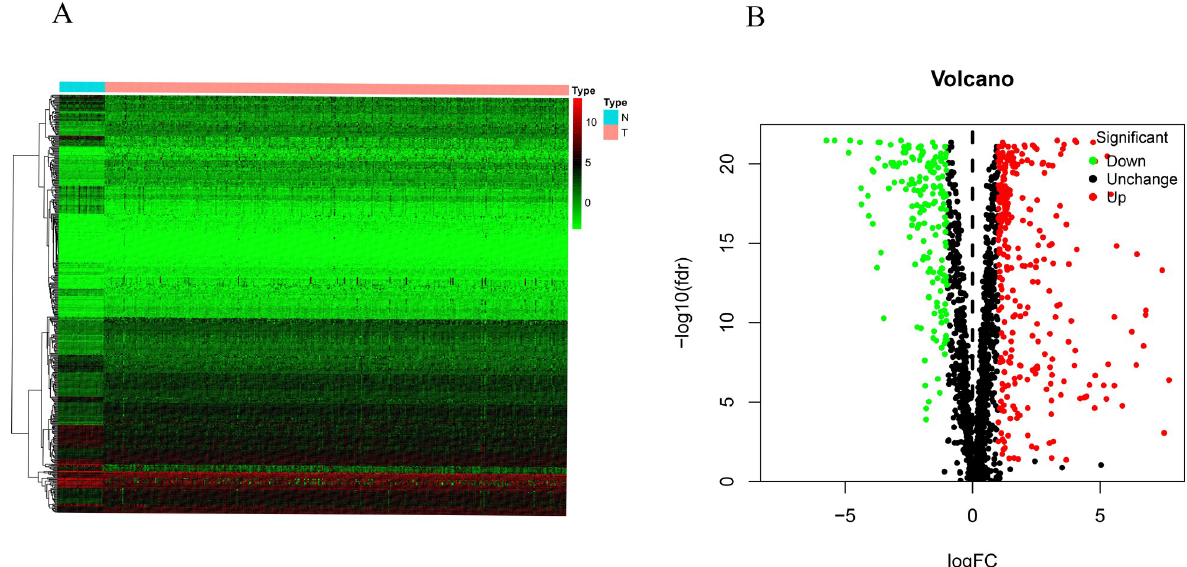
Fig 1. Heatmap and (B) volcano plot of differentially expressed MRGs (DEMRGs). Red and green show high and low gene expression levels, respectively; black indicates no significant difference in expression level.